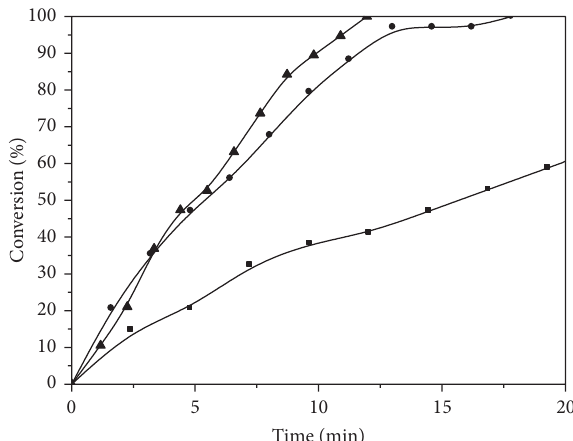
Figure 4: Hydrogenation of 1-hexene ( ∙ ), 1-decene ( 󳵳 ), and cyclo- hexene ( ◼ ) by Pd(0)/SiO 2 /HF under 4atm of H 2 (constant pressure) at 75 ∘ C, and [alkene]/[Pd(0)] = 1279 to 1-hexene, 752 to 1-decene and 1290 to